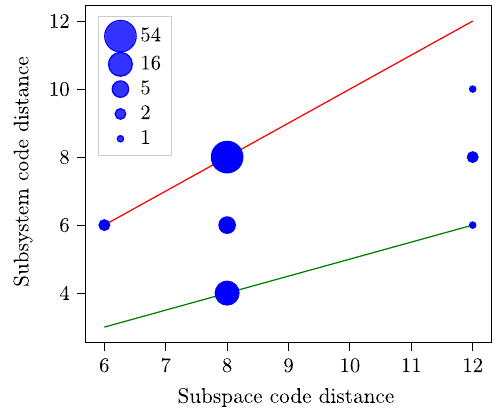
FIG. 28. For all l ¼ 2 f 8 ; 4 g subsystem semihyperbolic codes we construct, here we plot the distance of each code ( y axis) against the distance of the (subspace) semihyperbolic surface code derived from the same tessellation ( x axis) computed using the method in Ref. [60]. The size of each blue circle corresponds to the number of codes we find with the same ( x , y ) coordinate on the figure, and the number of codes for each size of circle is given in the